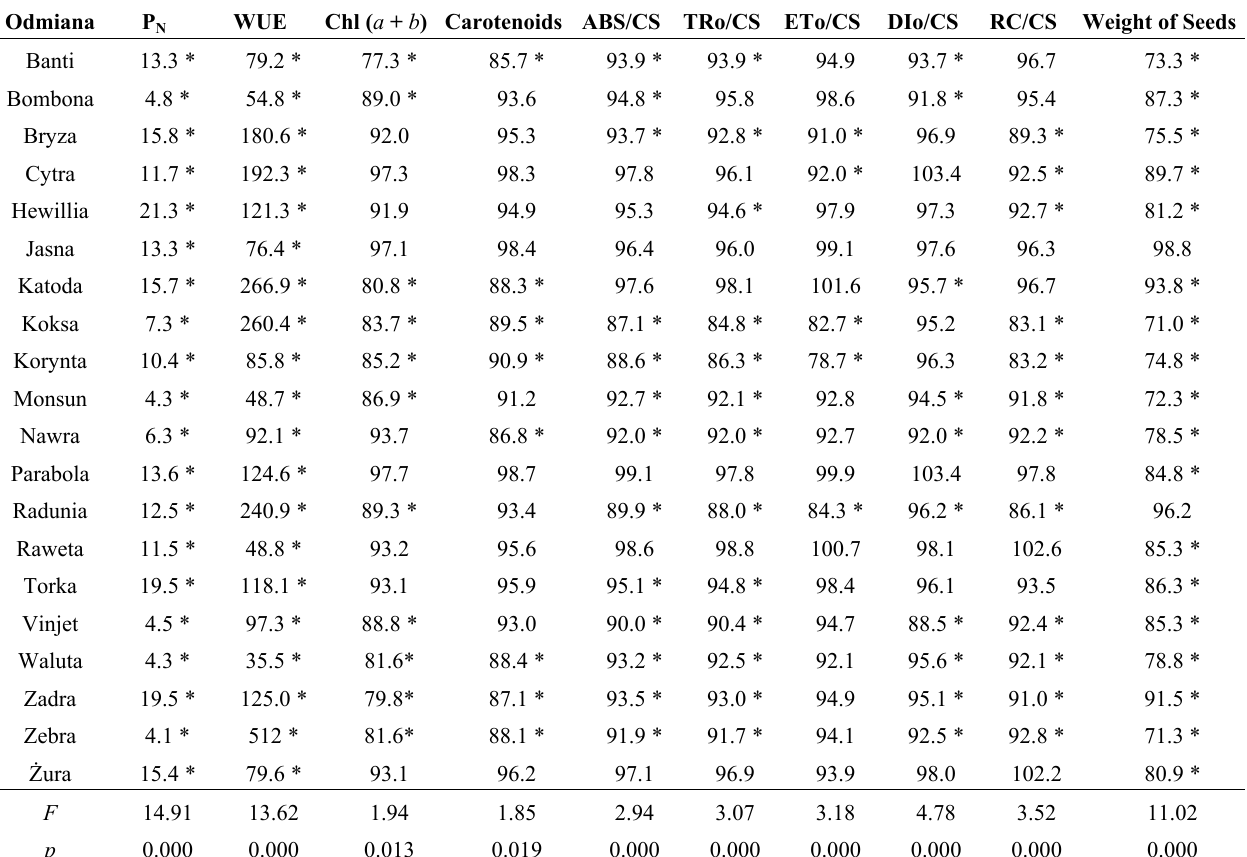
Table 3. Values of stress index of gas exchange, chlorophyll and carotenoids contents, parameters of photochemical efficiency (PSII) of seedling and final weight of seeds of 20 wheat varieties after 10 days of drought